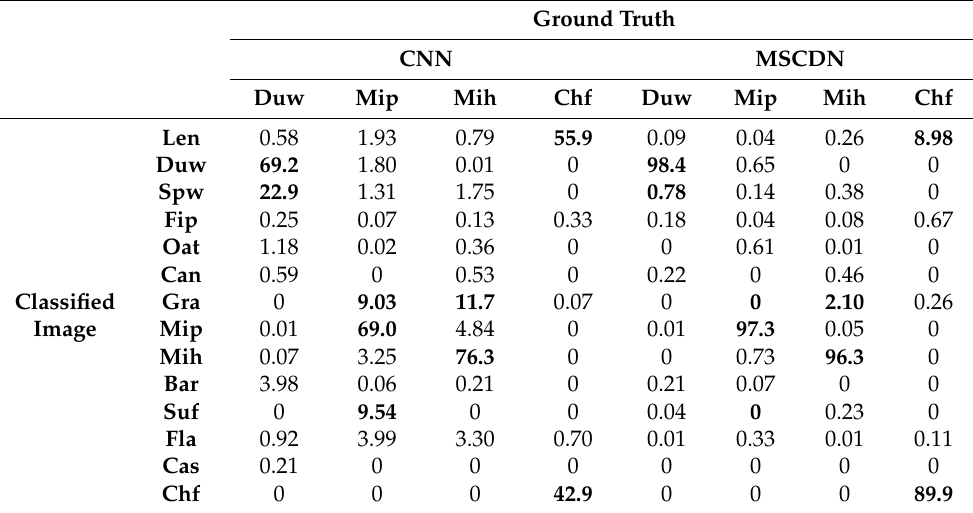
Table 6. The partial confusion matrix of crop classification for CNN and MSCDN.